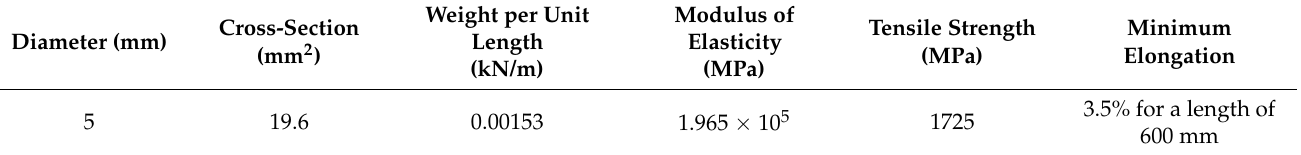
Table 3. Mechanical properties of prestressing wires.